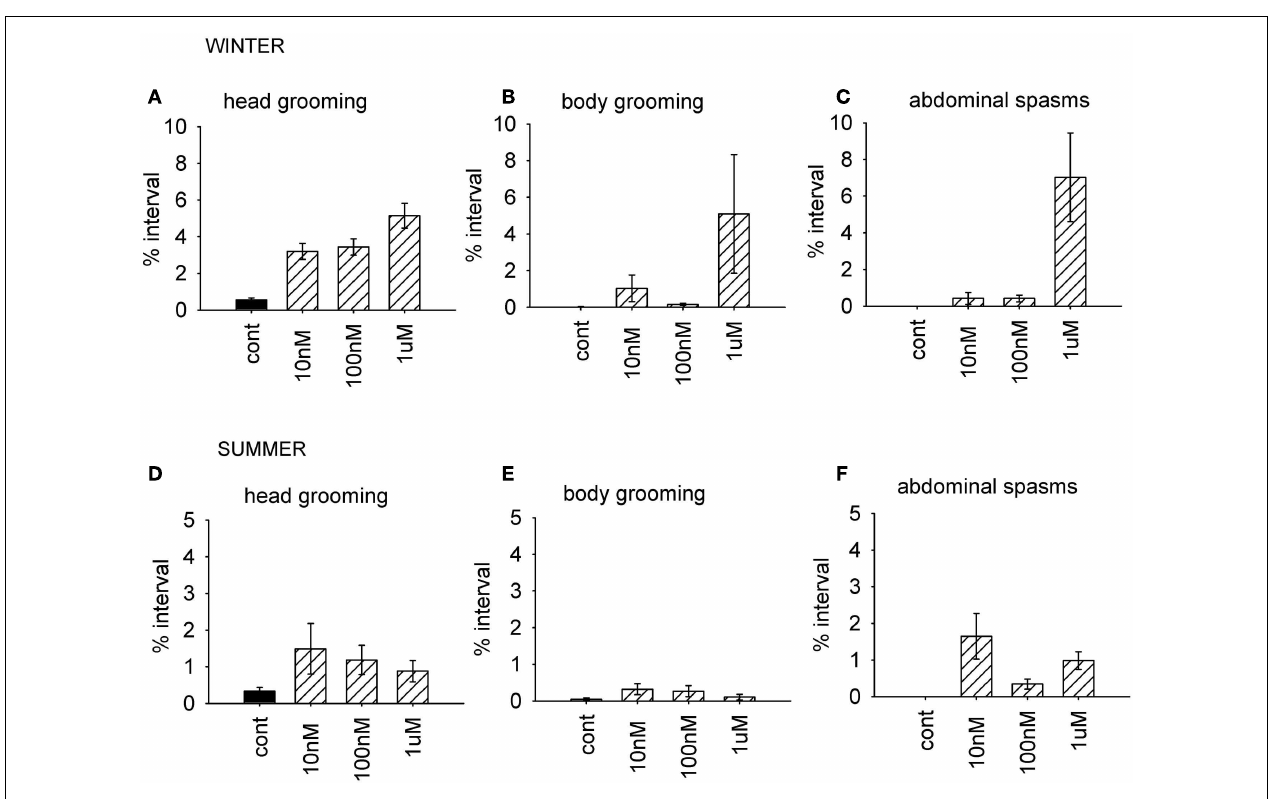
grooming, winter (B) body grooming, winter. (C) Abdominal spasms, winter. (D) Head grooming, summer. (E) Body grooming, summer. (F) Abdominal spasms, summer. N ≥ 10 For each treatment group and time of year. Cont, control;